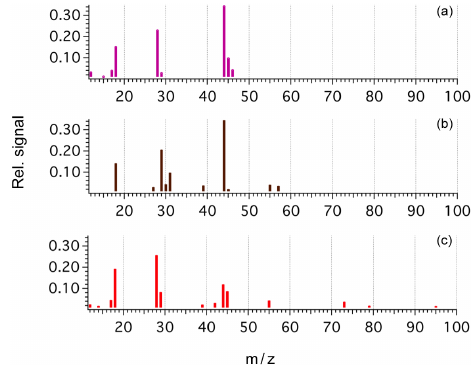
Figure 5. Measured mass spectra for oxalic acid (a) versus pre- dicted mass spectra from an ensemble tree using the FP4 fingerprint